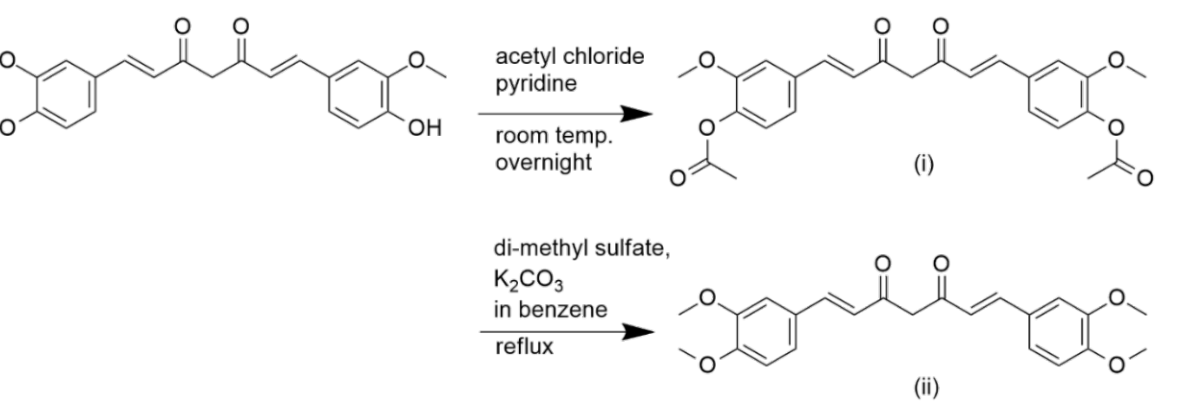
Figure 4. Chemical structure of curcumin with its two methoxy phenolic groups.